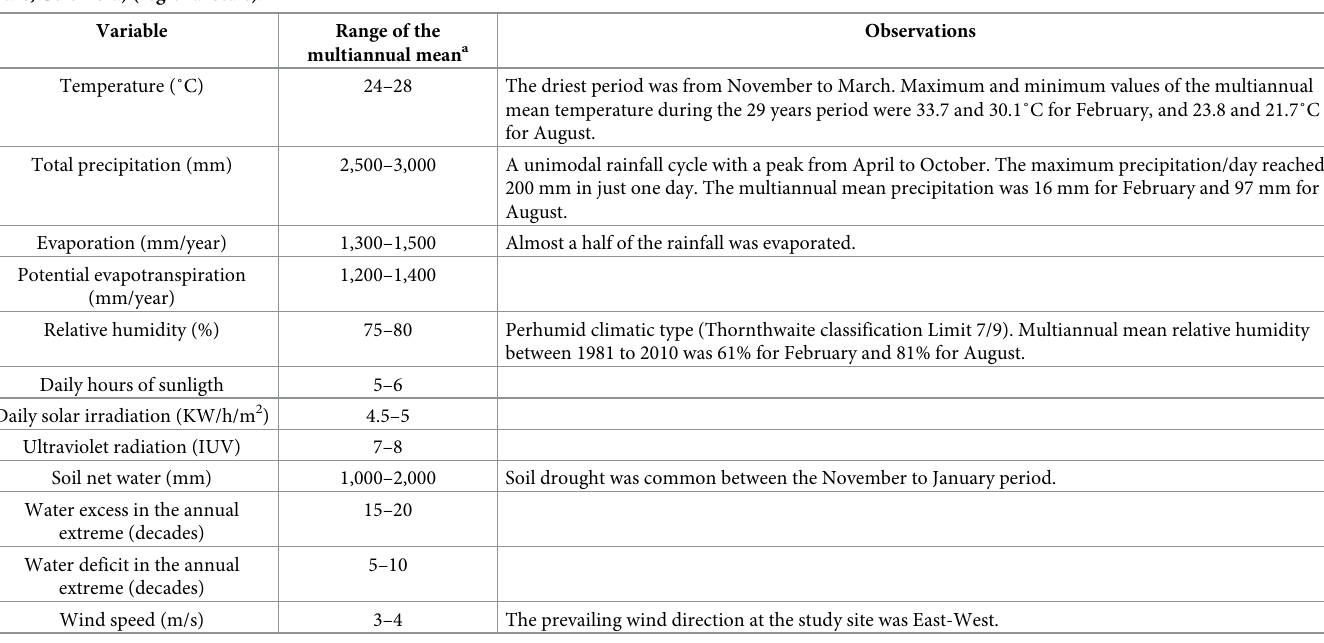
Table 6. Multiannual mean range for several climatic variables recorded for 29 years (1975–2004) in two weather stations located at the Yopal municipality (Casa- nare, Colombia) (regional scale).